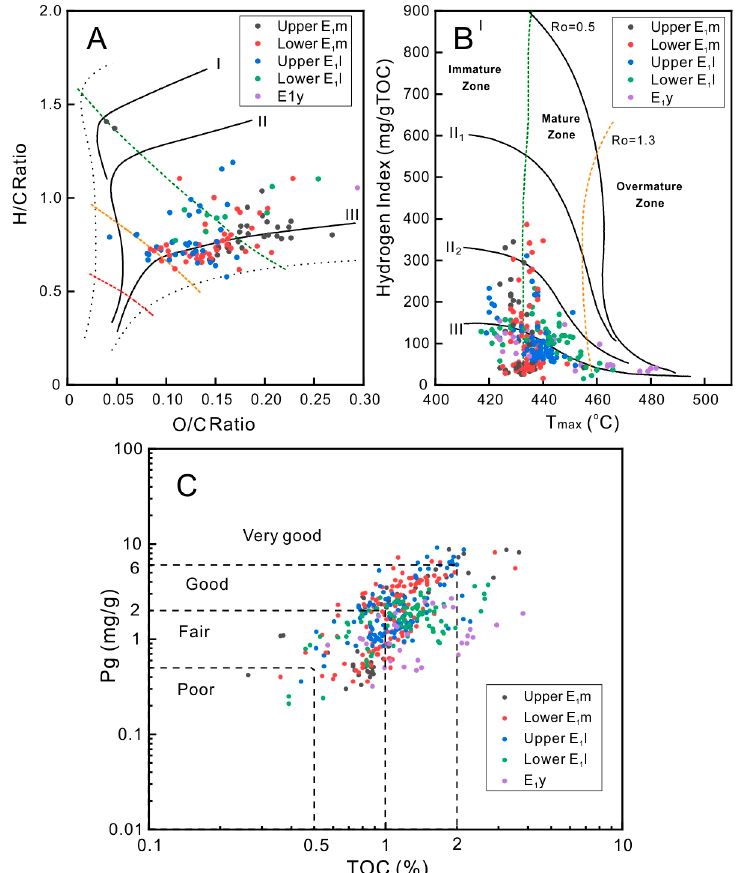
Figure 10. Source rock evaluation plots of the main source rocks from the study area in the Lishui Sag. ( A ) Kerogen type and maturation definition using van Krevelen diagram [41]. ( B ) Distribution of hydrogen index (HI) with pyrolysis peak temperature (Tmax) [42]. ( C ) Variation of Rock–Eval Pg (S 1 +S 2 ) with total organic carbon (TOC) content. In figure A and B the green dash line represents Ro = 0.5, the yellow dash line represents Ro = 1.3, and the red dash line represents Ro = 2.0. Table 3. The average value of source rock pyrolysis test data used in the model. TOC = Total organic carbon, S 1 = Free hydrocarbon components, S 2 = Hydrocarbons generated by the pyrolysis, HI = Hydrogen index, Tmax = Pyrolysis peak temperature. Formation